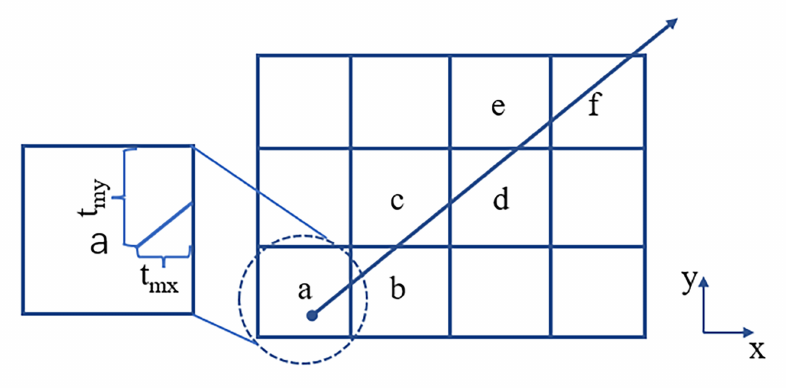
Figure 3. Ray traversal on the 2D grids. The letters a–f represent the orders of grids which the ray reaches.